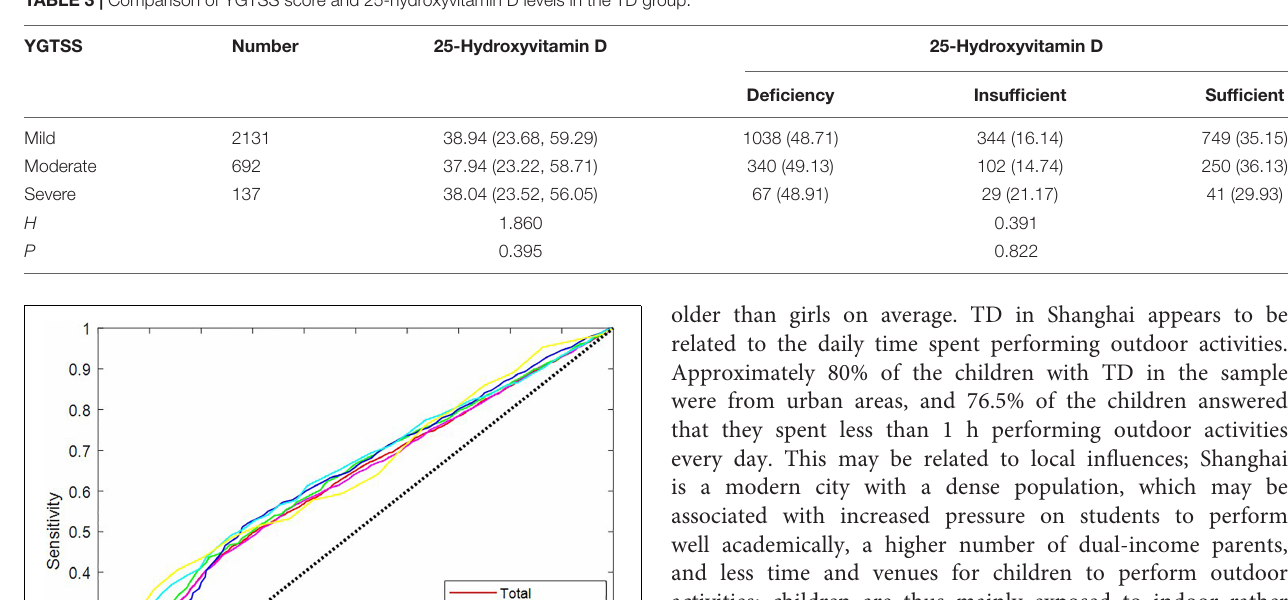
TABLE 3 | Comparison of YGTSS score and 25-hydroxyvitamin D levels in the TD group.